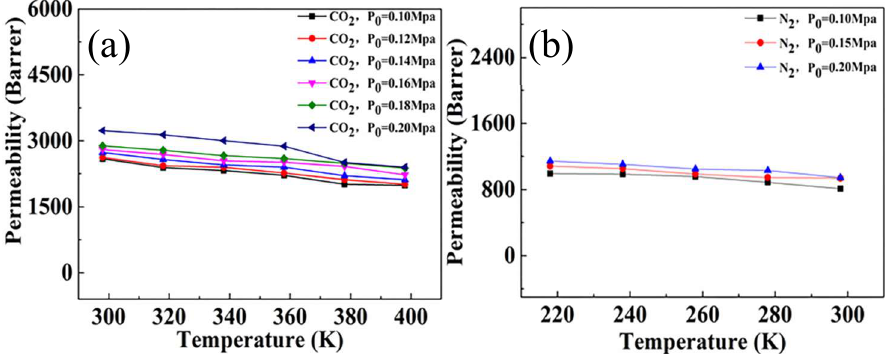
Figure 9. Gas separation performance of GO/SWCNTs/Pebax1657 for ( a ) CO 2 and ( b ) N 2 with the increase of temperature and pressure.